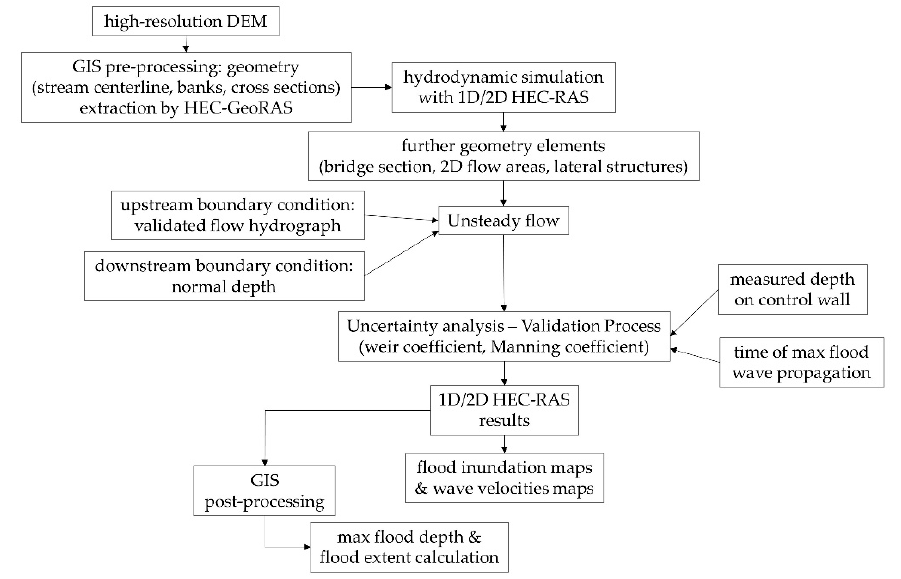
Figure 3. Diagram of the applied process.